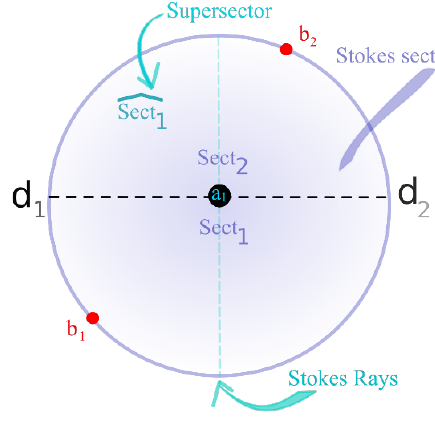
Figure 5 . Data needed to de(cid:12)ne a